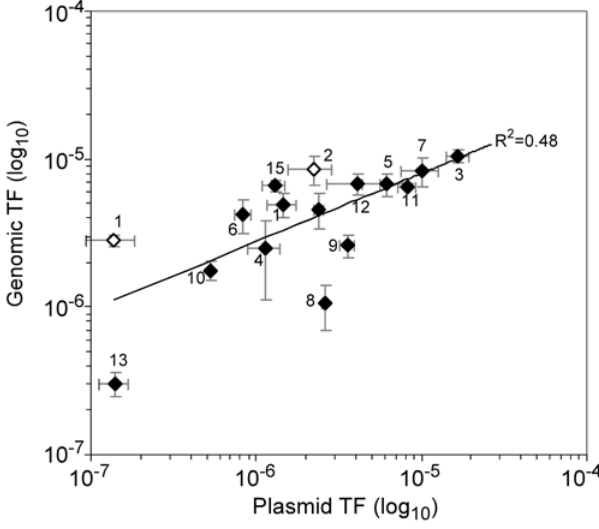
Figure 4. Correlation between recombination frequencies obtained with plasmid DNA and genomic DNA after natural transformation of R.solanacearum GMI1000 as recipient. Donor DNA belongs to the same strain and was either plasmid DNA containing 2 kb long R. solanacearum DNA or genomic DNA from recombinant strains (see the text). The numbers along the curves refer to the DNA position acronym with white and black symbols for chromosome and megaplasmid positions, respectively (TCP2 , detection limit, TMP3, not determined). TF, transformation frequency.